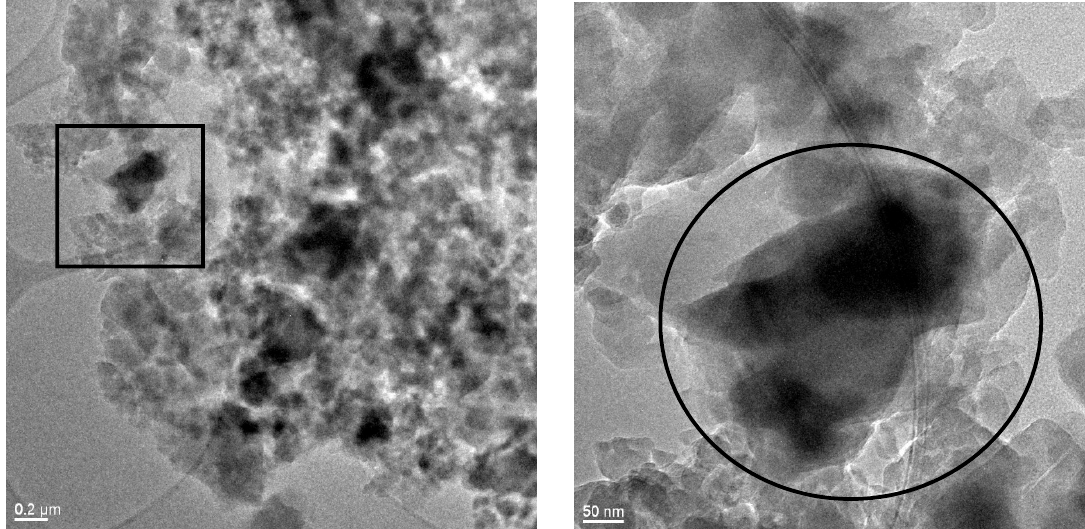
Figure 6. TEM images showing a ZIF-8/PVDF composite layer with 40% PVDF, at different magnification levels. EDS analysis of the selected area (right image) revealed a strong zinc signal, thus confirming the presence of ZIF-8 in the particle agglomeration (see Figure S2).